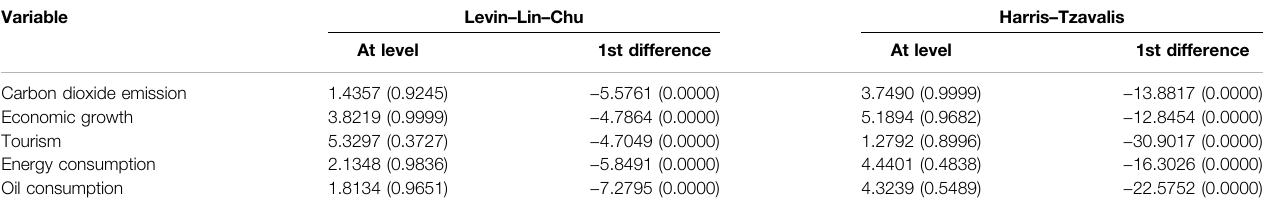
TABLE 1 | Panel unit root tests.